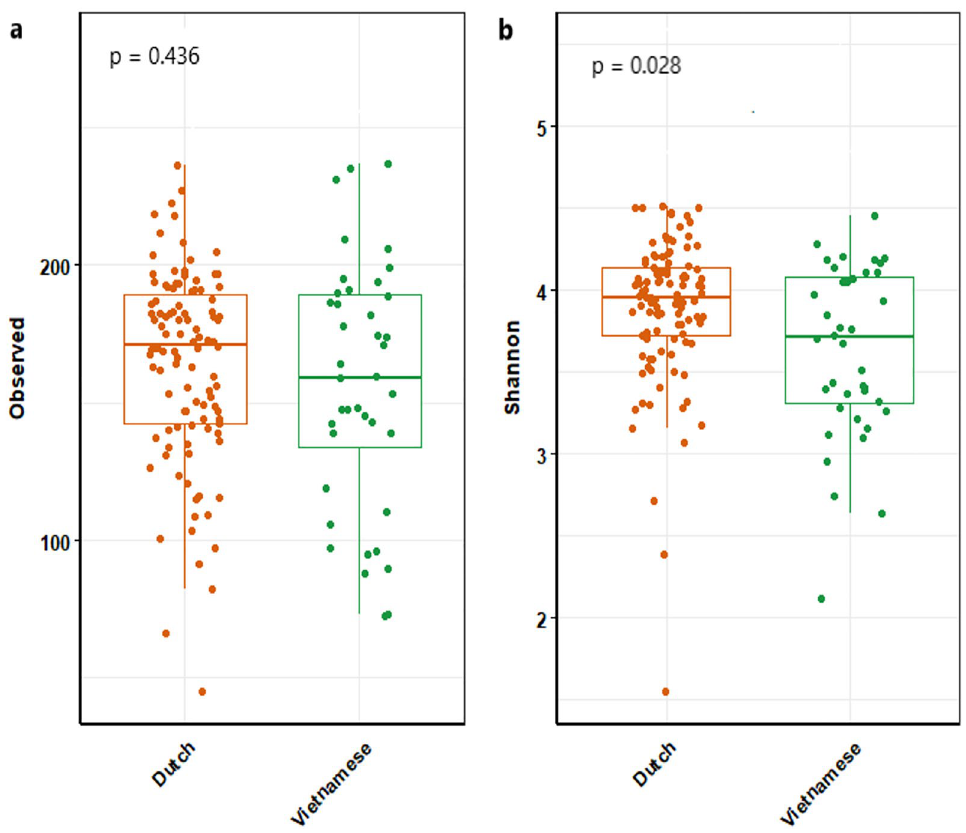
Figure 4. Microbial richness ( a ) and diversity ( b ) in Vietnamese (n = 57) and Dutch healthy adults (n = 106) who did not use antibiotics for at least one year prior to sampling. P-values are based upon linear regression analysis with adjustment for age and